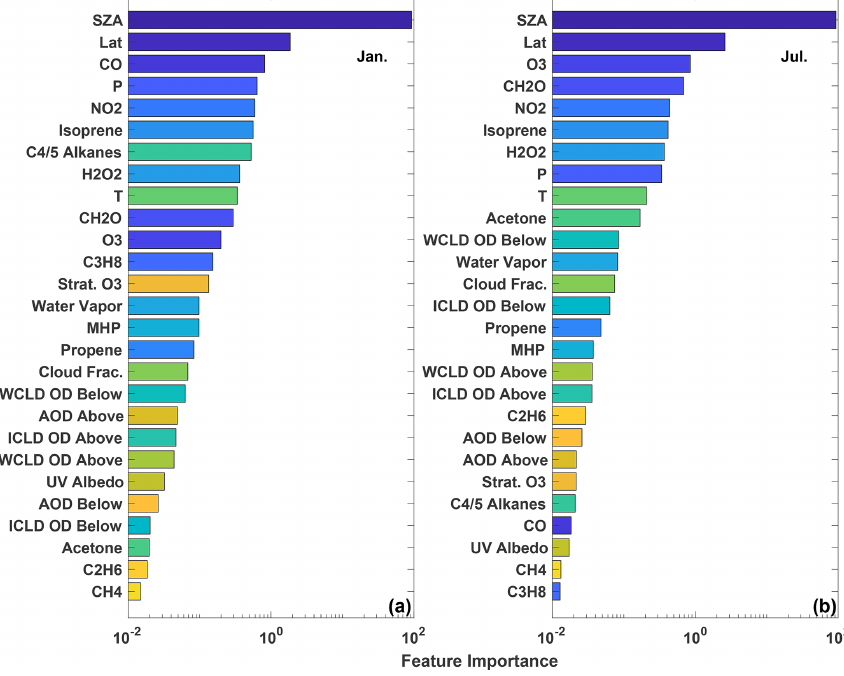
Figure 5. The feature importance (gains) of the January (a) and July (b) parameterizations as calculated by XGBoost. Variables are sorted by their relative importance. WCLD stands for water cloud, ICLD stands for ice cloud, and OD stands for optical depth. “Above” and “below” for the optical depth variables indicate the optical depth above and below a particular model grid box. Colors are assigned to the variables to permit easier comparison of the